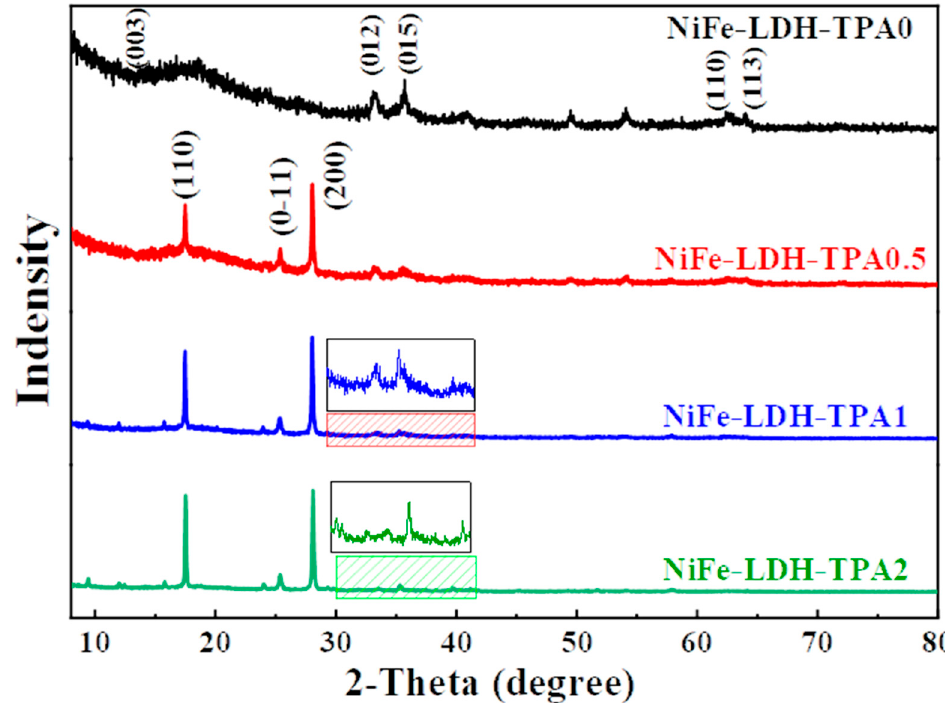
Figure 2. XRD measurements. XRD for NiFe-LDH-TPA0 (black line), NiFe-LDH-TPA0.5 (red line), NiFe-LDH-TPA1 (blue line), and NiFe-LDH-TPA2 (green line).